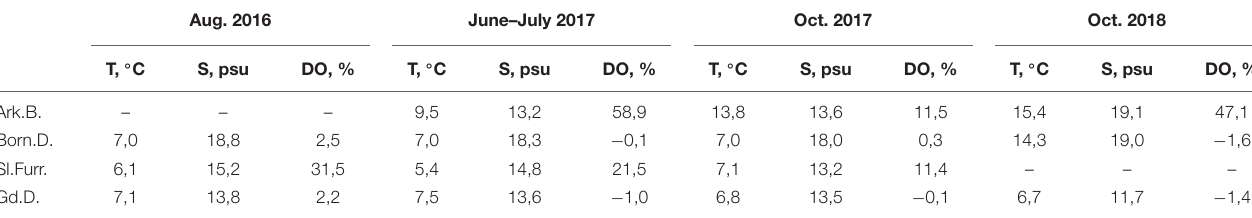
FIGURE 8 | Distributions of temperature T ( ◦ C), salinity S (psu), density σ θ , and oxygen saturation O 2 (%) in the southern Baltic for the 3rd survey (October 2017); bottom panels demonstrate graphs of the same parameters in the bottom layer. TABLE 1 | Maximum bottom temperature, salinity and minimum dissolved oxygen (DO) saturation at the transects through the southern Baltic basins. Aug.